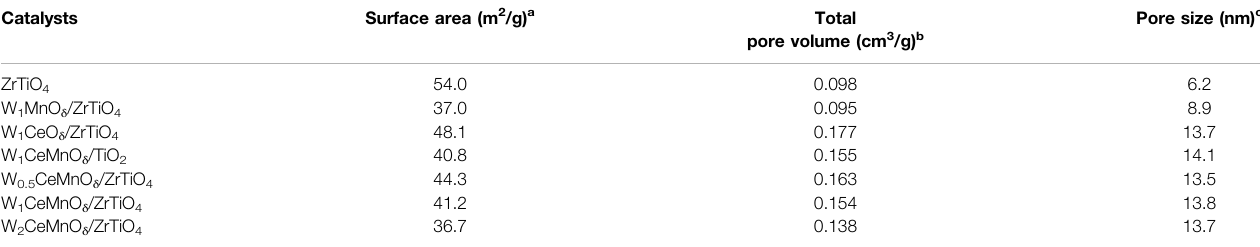
TABLE 2 | Textural properties of 3DOM ZrTiO 4 and W x CeMnO δ /3DOM ZrTiO 4 catalysts. Catalysts